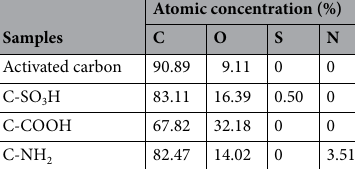
Table 1. Atomic concentrations of the untreated carbon and functionalised carbon samples.